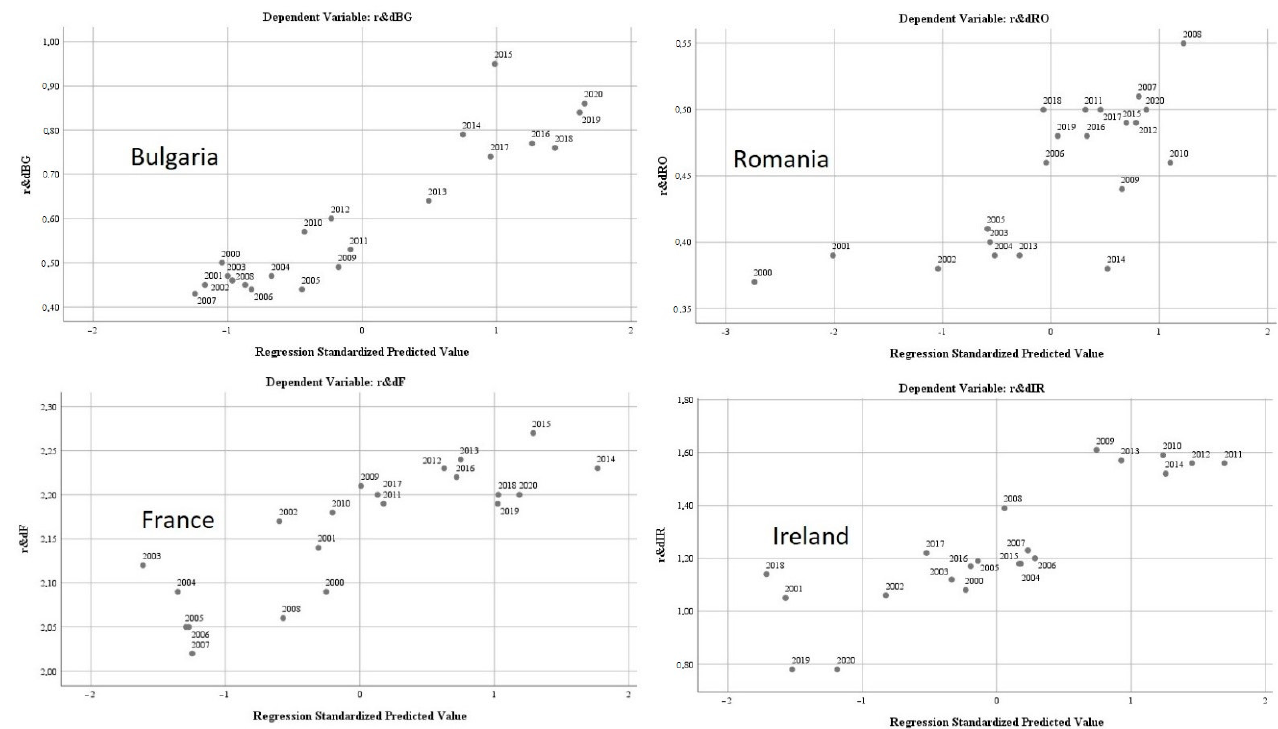
Figure 9. Regression analysis on two levels. Source: Data operated under IBM-SPSS 25 (IBM, Armonk, NY, USA).